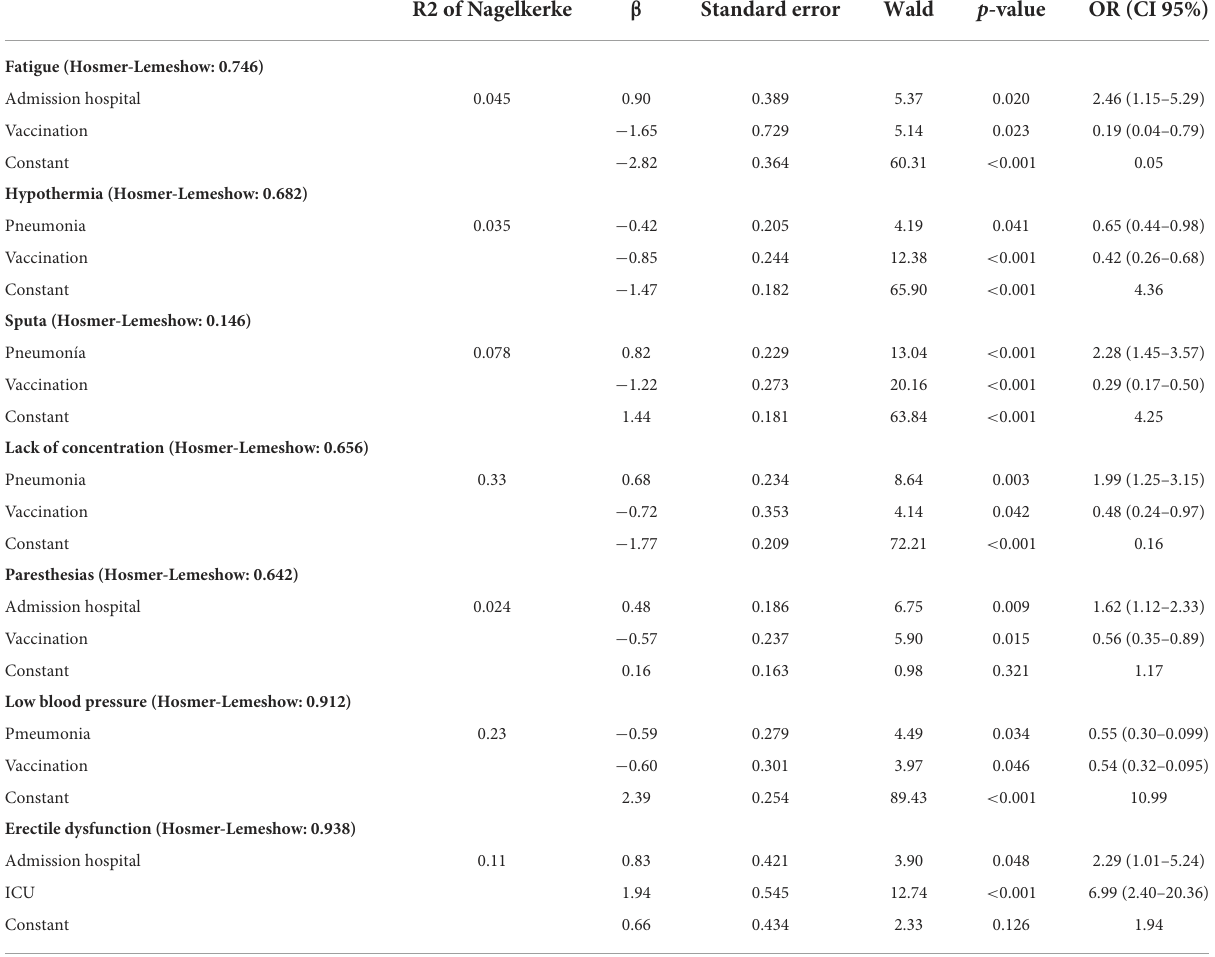
TABLE 7 Binary logistic regression: long COVID symptoms – significant OR variables. R2 of Nagelkerke β Standard